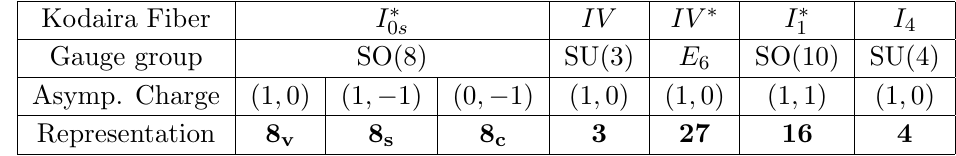
Table 2 . Example representations obtained by searching for all junctions J with the given asymp- totic charge and ( J; J ) = (cid:0)